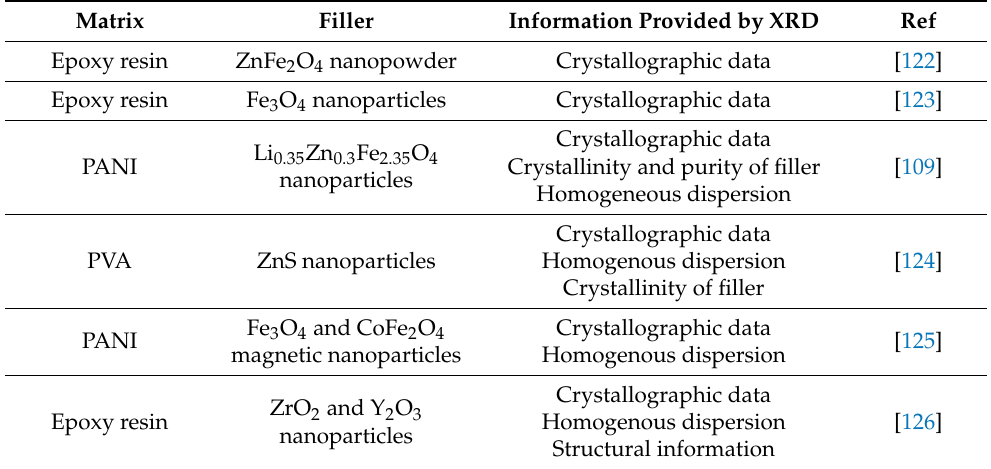
Table 4. Information provided by XRD for polymer nanocomposites.